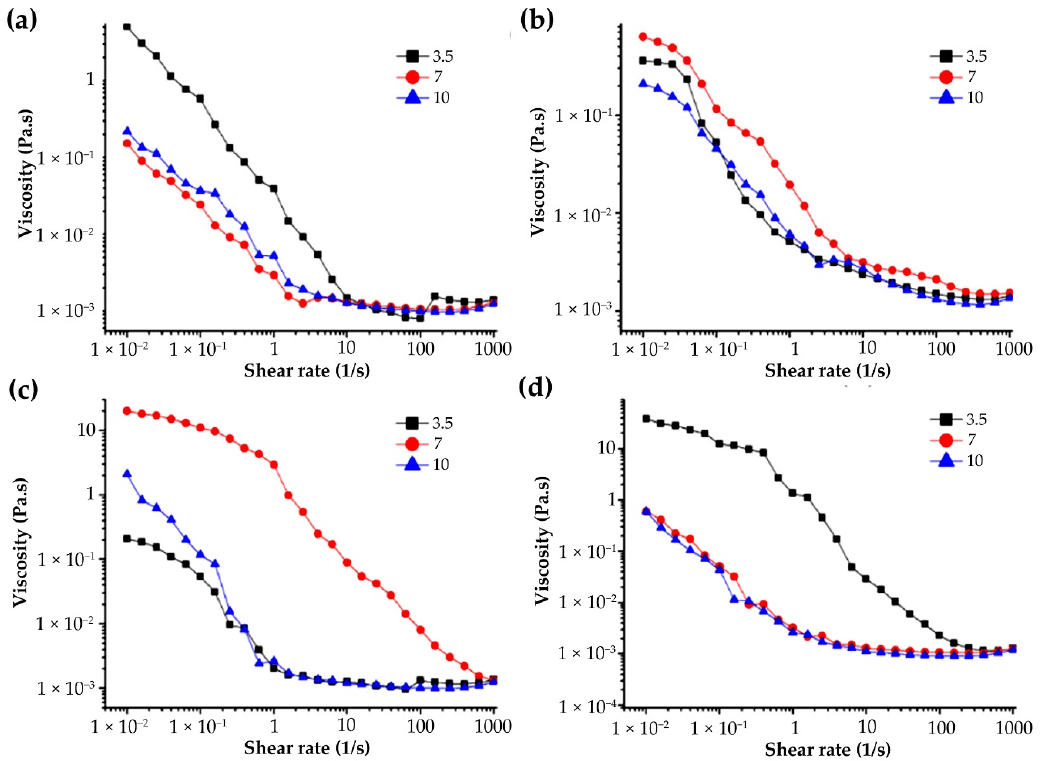
Figure 6. Effect of pH on the viscosity of G ‐ MLPs. ( a ) G ‐ HBSS; ( b ) G ‐ CHSS; ( c ) G ‐ DASS; ( d ) G ‐ CASS.